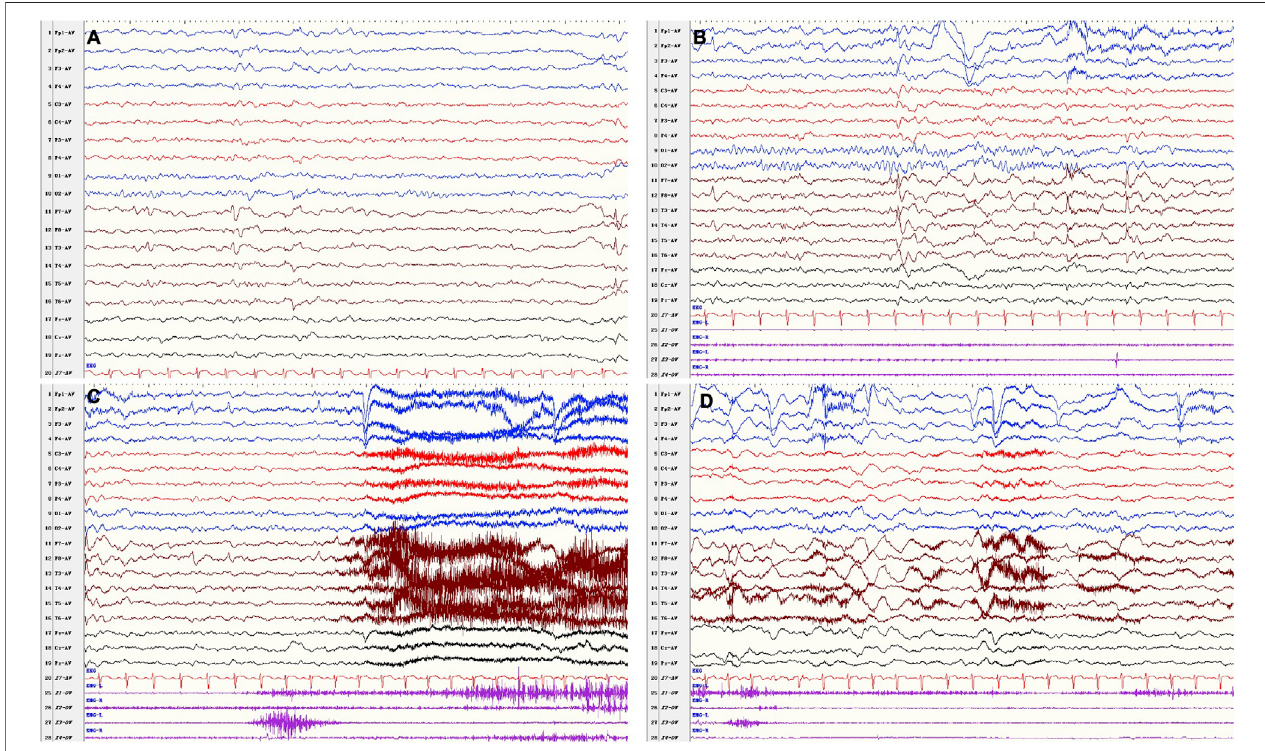
FIGURE3| VEEGafterdrugwithdrawalat10years8months.Interictal (A,B) :bilateralfrontal – temporalepileptiformdischarges, (B) wasthebackgroundafewseconds before the onset. Ictal (C,D) recorded a focal seizure (fear, closed eyes, vocalization, forward and backward movements of the hips, pedaling movements of lower limbs) in awake